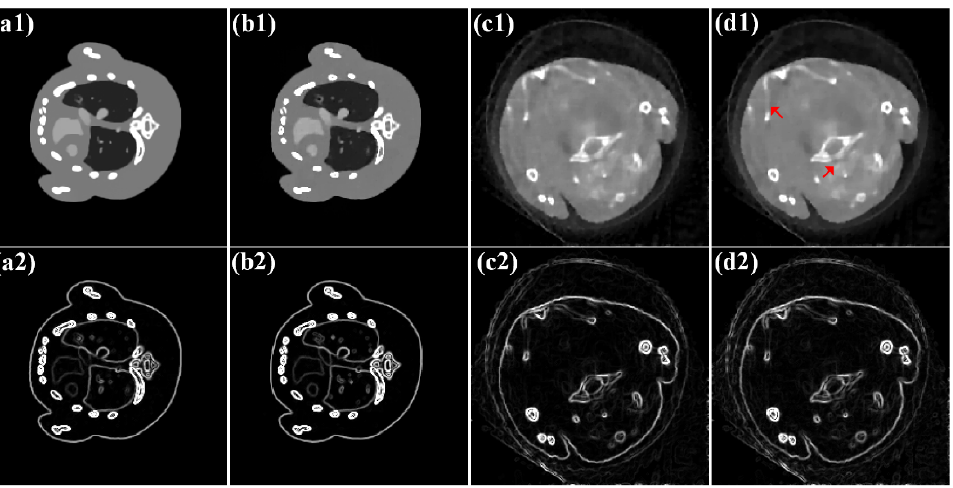
Figure 13. Comparison of the results of TDL with only L 0 -norm and our algorithm. The first row is the reconstruction results, the second row is the corresponding gradient images. ( a , c ) TDL with only L 0 -norm; ( b , d ) our algorithm.